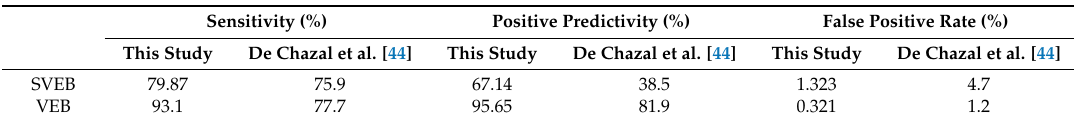
Table 4. The SVEB (i.e., APC) and VEB (i.e., VPC) result